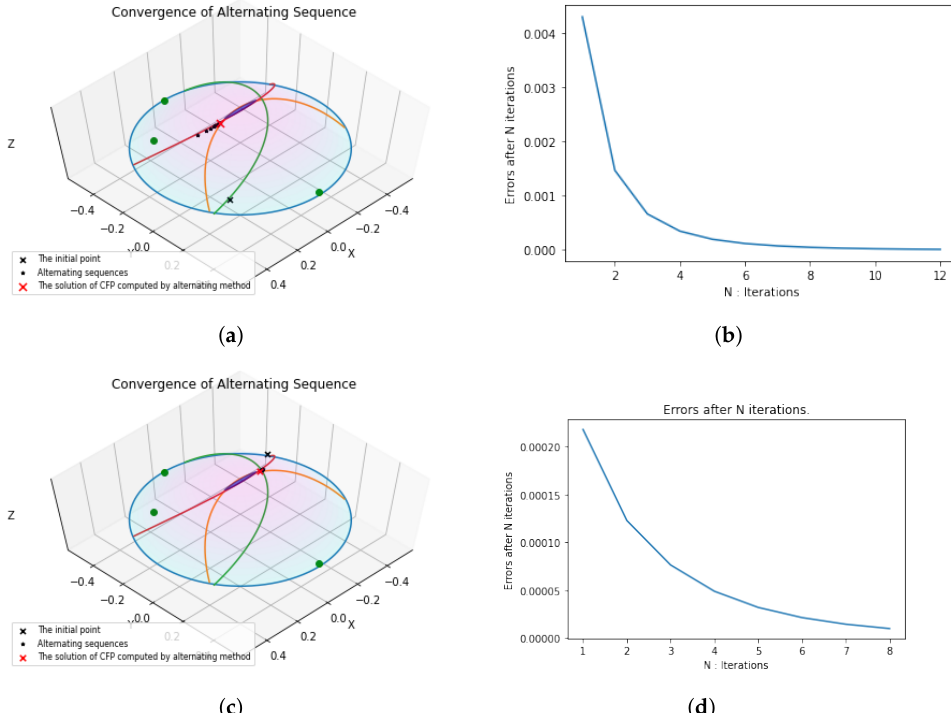
Figure 2. Results of the implementation of the alternating method to an approximate the solution of √ √ √ CFP. ( a ) The alternating sequence x N on space X when x 0 = ( 0.12, 0.08, 0.80 ) and its conver- d ( x N , C i ) 2 . ( c ) The alternating sequence x N gence. ( b ) Errors after N iterations computed by ∑ 3 −√ −√ √ i = 1 on space X when x 0 = ( 0.12, 0.03, 0.85 ) and its convergence. ( d ) Errors after N iterations d ( x N , C i ) 2 computed by ∑ 3 i = 1